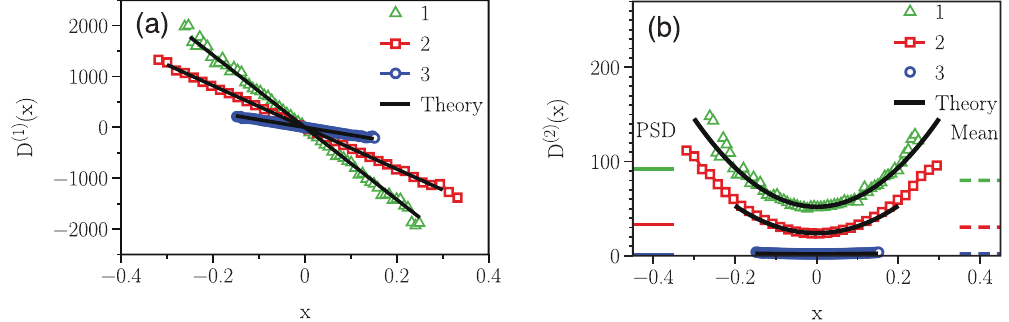
Figure 5. Reconstruction of a non-linear Langevin process. The KM-based estimated drift function ( a ) and diffusion coefficient ( b ) for the synthetic time series with D (1) ( x ) = − Qx and position-dependent diffusion coefficient, D (2) ( x ) = D 0 + bx 2 . Cases (1), (2) and (3) represent the parameter sets ( Q , D 0 , b ) ≡ (7100, 52, 1040), (4100, 24, 506) and (1500, 2, 28), respectively. The diffusion coefficient estimated by PS method and the KM average value are shown as small horizontal colored lines in panel (b).